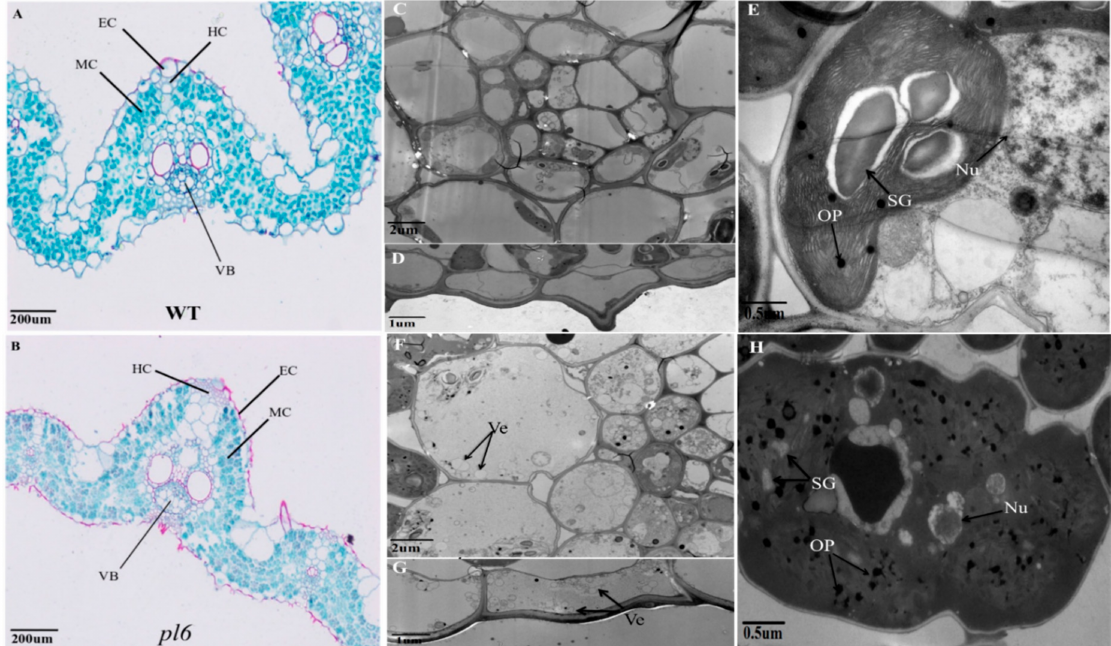
Figure 4. Transverse section and transmission electron microscopic images of the leaf blade between the WT and the pl6 mutant; ( B , A ) Transverse section of a leaf blade of WT and pl6 at the late tillering stage; ( C , F ) Transmission electron microscopic images of vascular cells at the late tillering stage, respectively; Bar = 2 µ m; ( D , G ) Closed up images of epidermal cells, Bar = 1 µ m; ( E , H ) Ultrastructure of mesophyll cells in the leaf of WT and pl6 , Bar = 0.5 µ m; MC, Mesophyll Cells; HC, Hypodermis cells; EC, Epidermal cells; VB, Vascular bundles; SG, Starch granules; OP, Osmophilic Plastoglobuli; Nu, Nucleous; Ve, Vesicles,